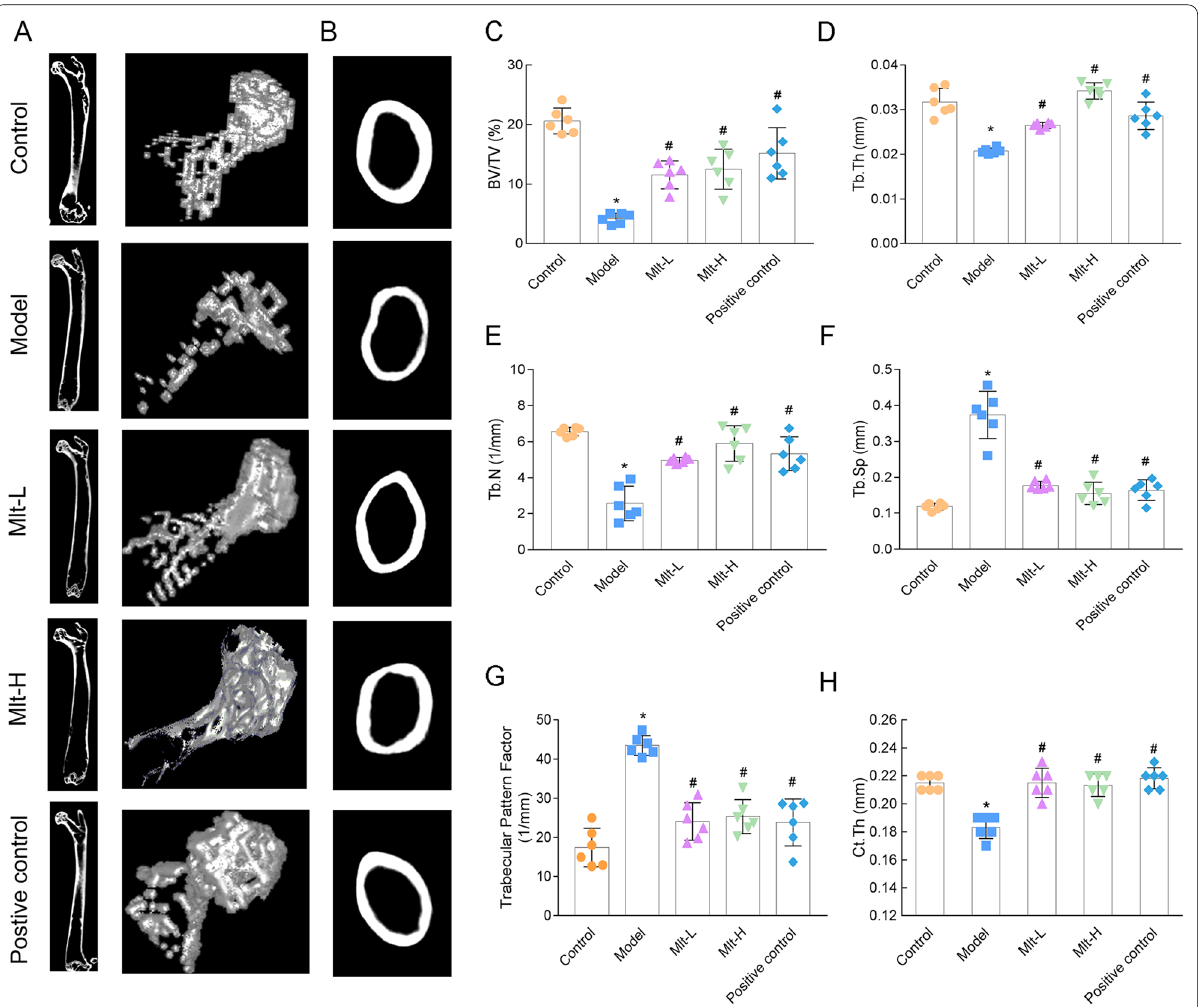
Fig. 4 Effect of melatonin on the femur microstructure of osteoporosis (OP) model mice. a and b Micro-CT detection after the administration of melatonin or alendronate. Images of 2D and 3D reconstruction obtained by micro-CT showed that the model group had a reduction in the number of femoral trabeculae and the thickness of femur diaphysis. Microstructure parameters of BV/TV ( c ), Tb. Th ( d ), Tb. N ( e ), Tb. Sp ( f ), trabecular pattern factor ( g ), and Ct. Th ( h ) were improved in melatonin-treated mice. Control: normal mice, Model: retinoic acid (RA)-induced OP model mice, Mlt-L: low-dose melatonin-treated OP model mice, Mlt-H: high-dose melatonin-treated OP model mice. Positive control: alendronatetreated OP mice. *, P < 0.05 vs control. #, P < 0.05 vs model; n 6 per =